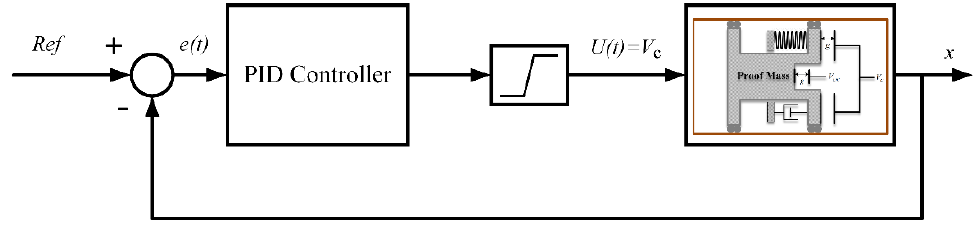
Figure 2. Schematics of the system along with the controller mechanism .